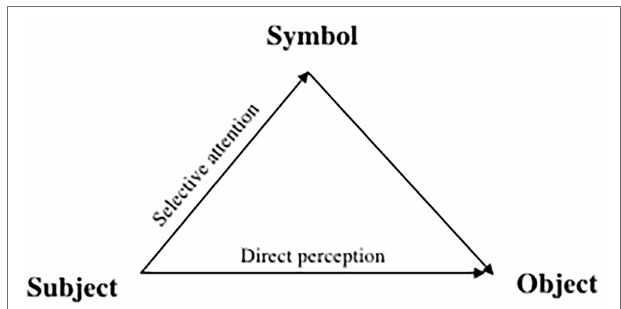
FIGURE 3 | Cognitive strategies used by participants in the Alternative Uses Task (AUT). FIGURE 2 | Mediational triangle. Adapted from Vygotsky